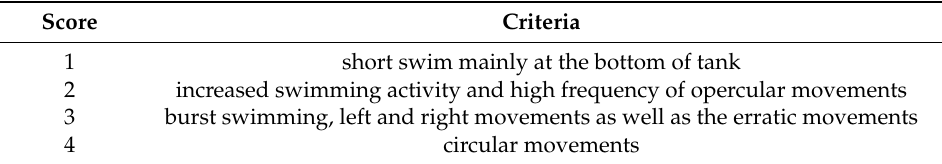
Table 3. Seizure scoring